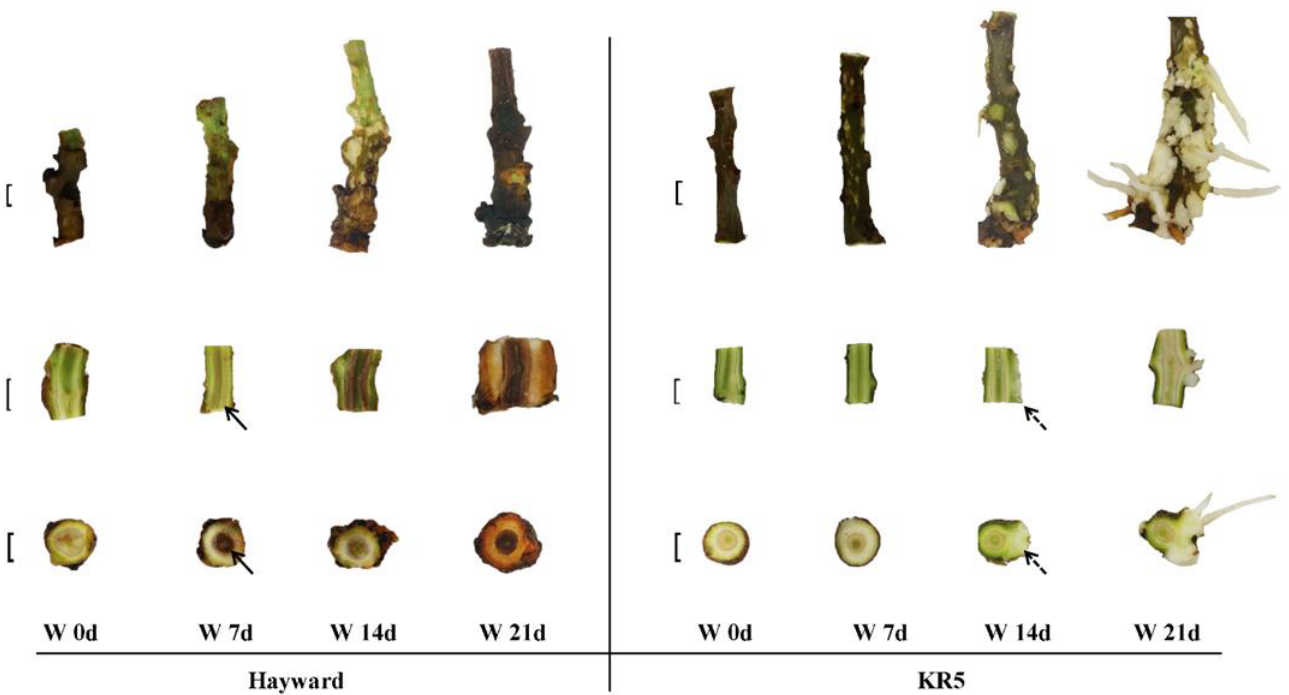
Figure 3. Morphological changes of ’Hayward’ and KR5 stem bases under waterlogging stress. W 0d, W 7d, W 14d, and W 21d indicate 0, 7, 14, and 21 d after waterlogging stress, respectively. Solid arrows show the early damage to tissues of ’Hayward’ after 7 d of waterlogging and dashed arrows show the newly formed calluses in KR5 after 14 d of waterlogging stress. Bar = 0.5 cm.